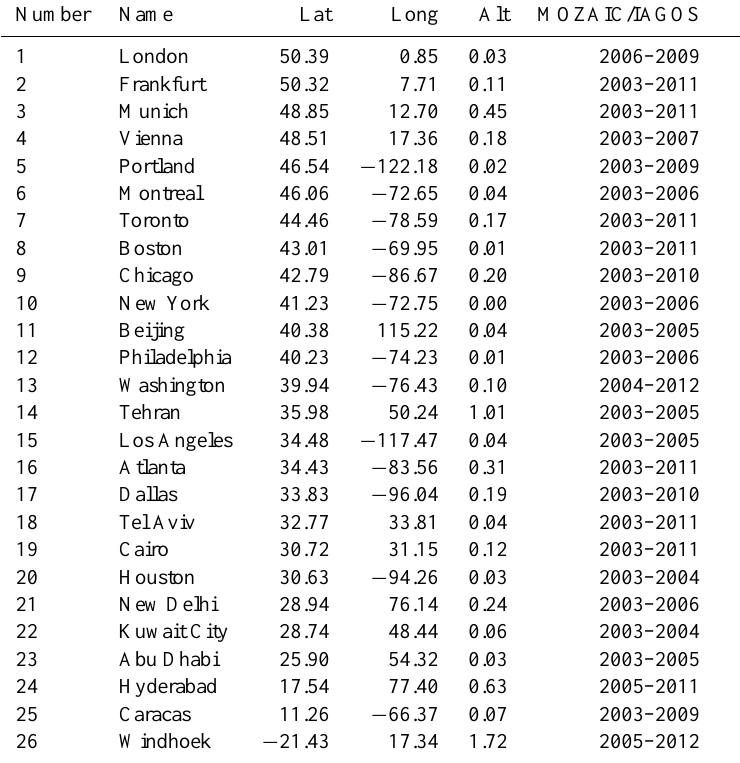
Table 3. As Table 2, but for MOZAIC/IAGOS airports